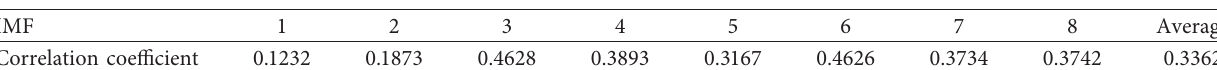
Figure 9: PSO-VMD decomposition. Table 2: Correlation